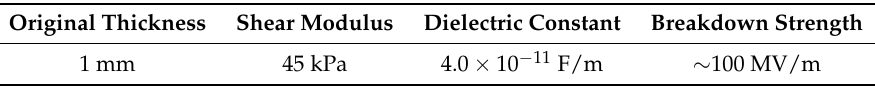
Table 1. Material properties of VHB 4910.